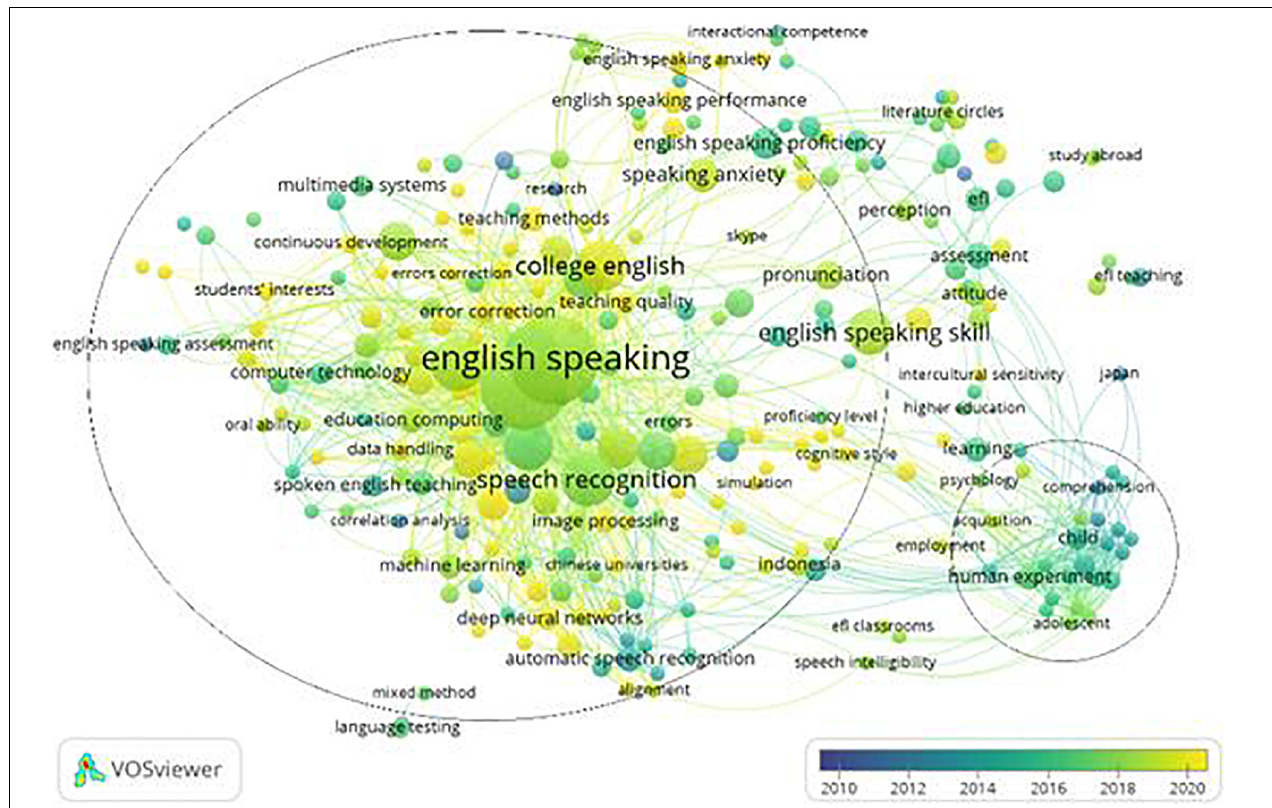
FIGURE 8 | The overlay visualization map of keywords according to